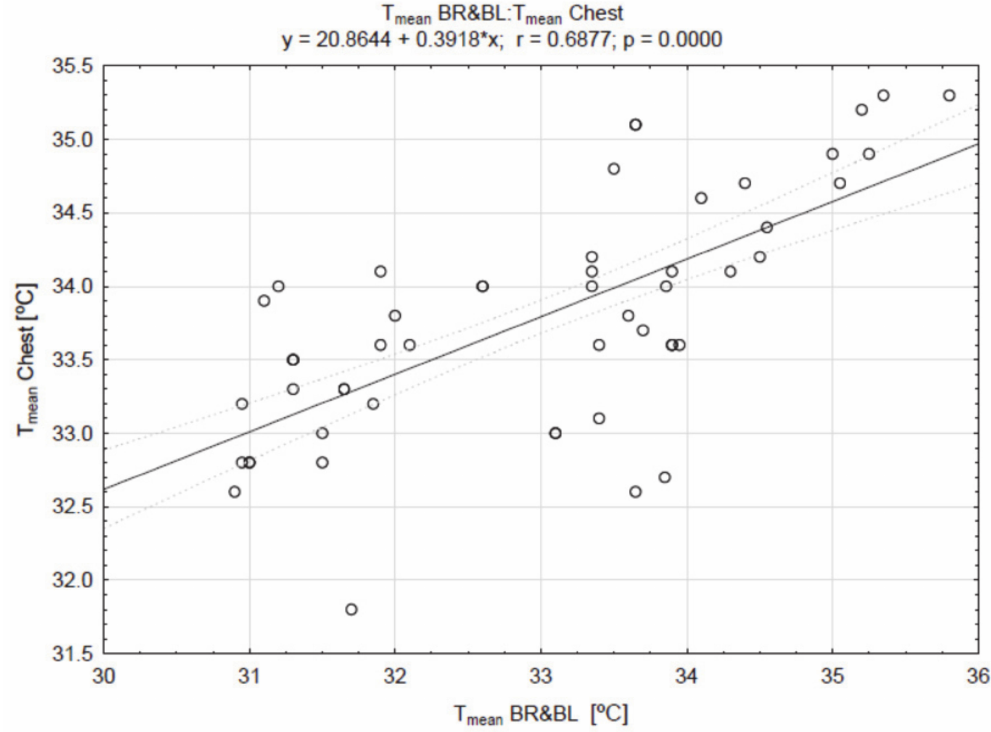
Figure 3. The result of the correlation between the values of breast (BR & BL) and chest temperatures (T mean